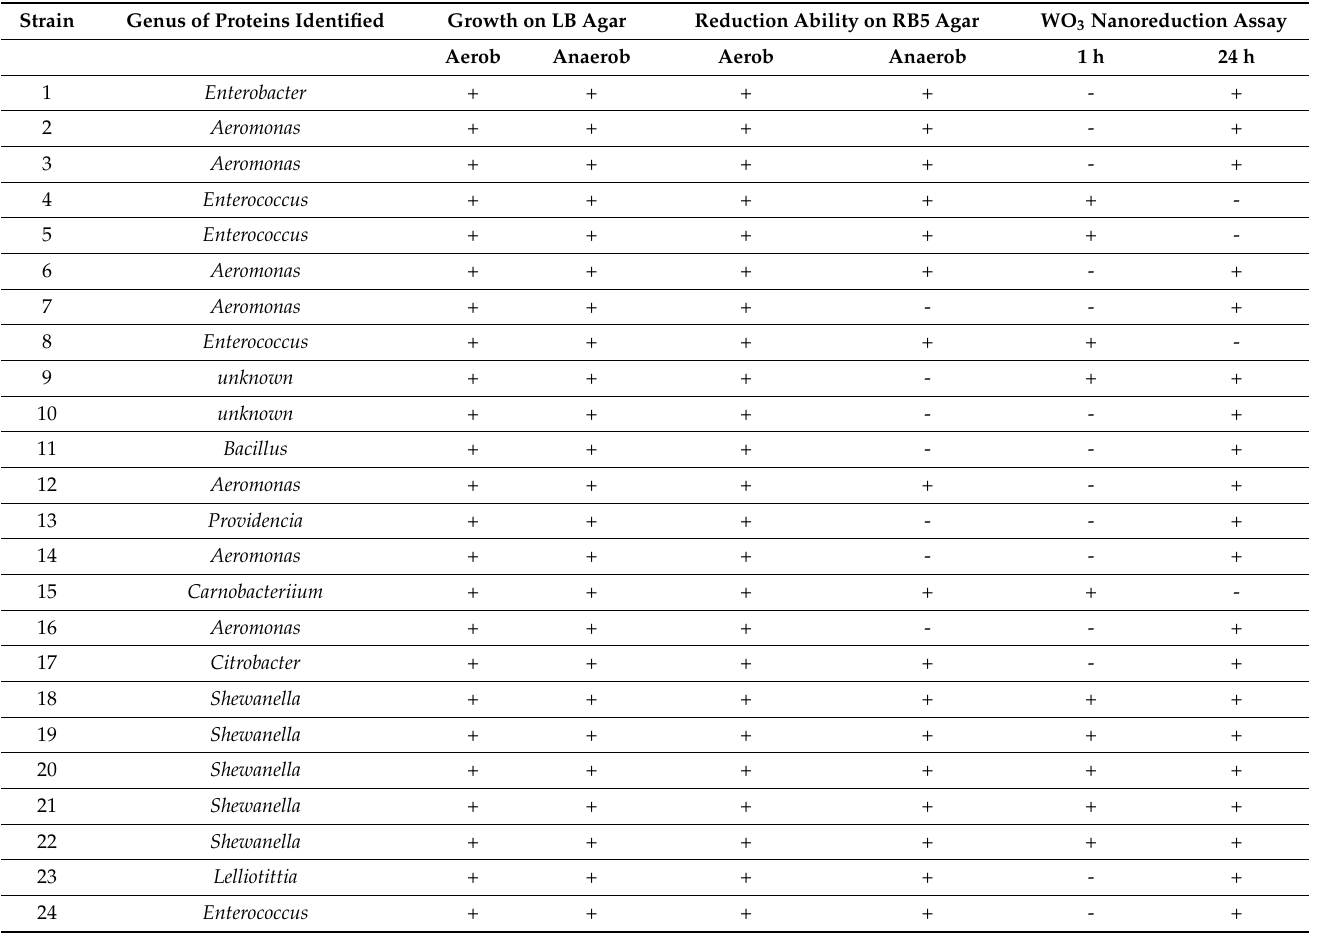
Table 1. Identities and electrogenic potentials of the bacterium isolates collected from mud samples during this study. Electrogenic potentials were revealed on the Reactive Black (RB5) agar plate assay and WO 3 nanorod reduction assay. (“+” means that they were positive for the test, while “-” means they were negative).